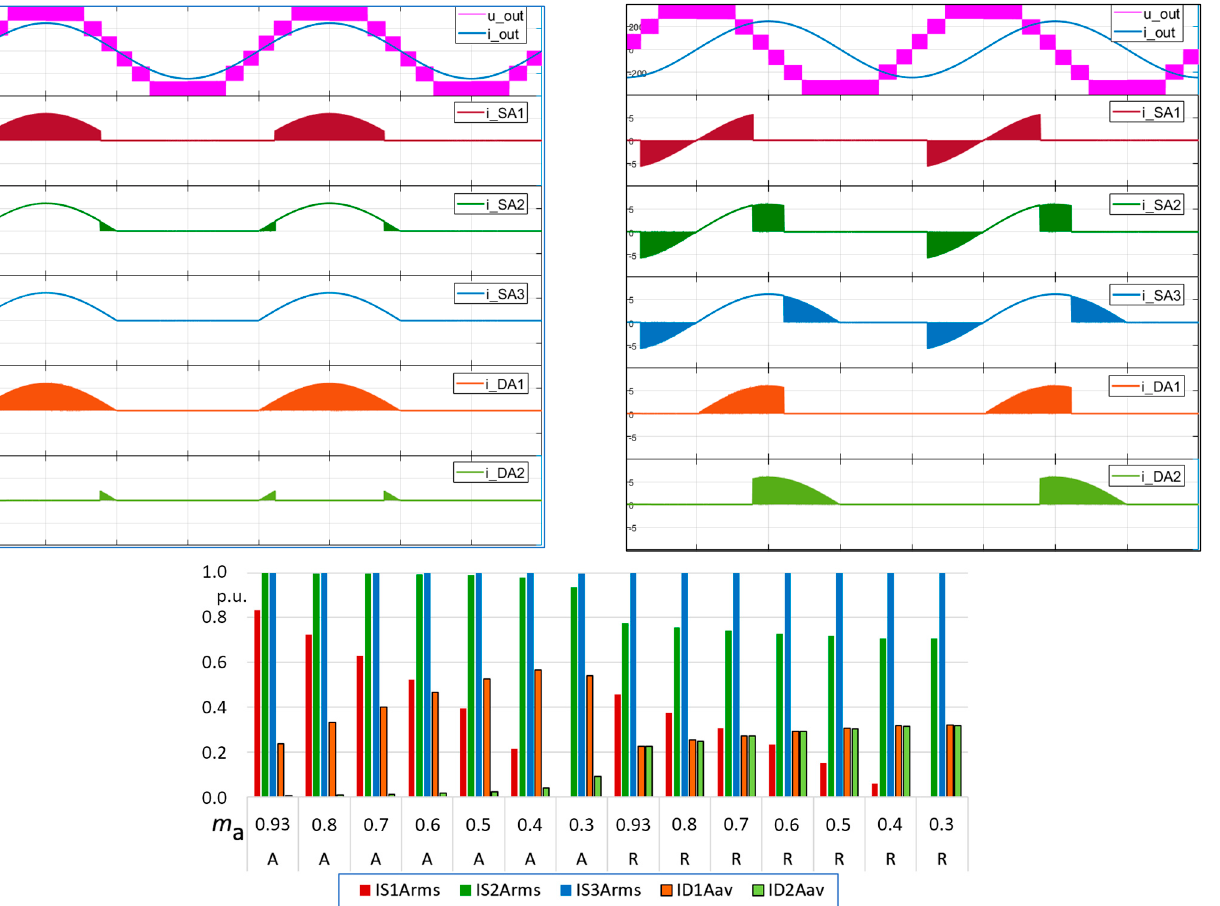
Figure 18. Current load of the inverter switches S 1A , S 2A , S 3A, and diodes D 1A and D 2A under the operation with pure active (A) and reactive power (R), as well as an impact of the modulation index. By symmetry, values of currents of other switches corresponds to the presented data.